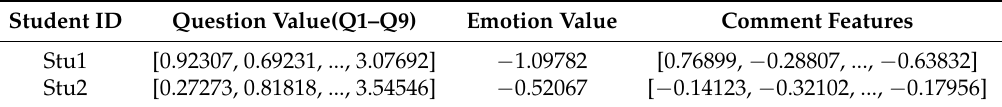
Table 2. Samples of processed students’ feedback